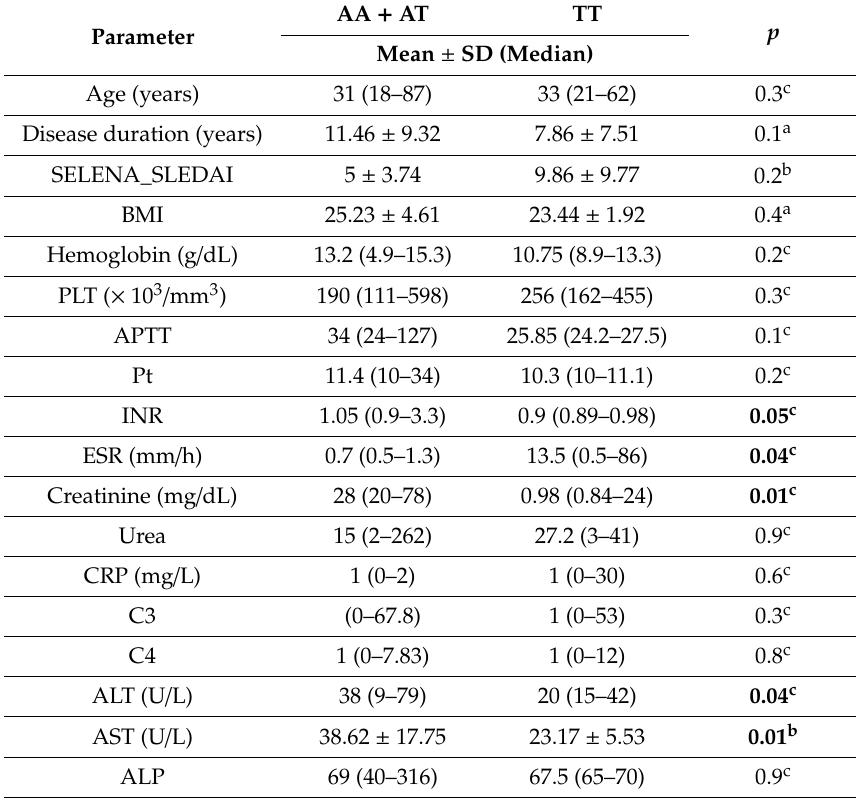
Table 5. Disease activity and laboratory variables in relation to MECP2 rs17435 A / T, recessive